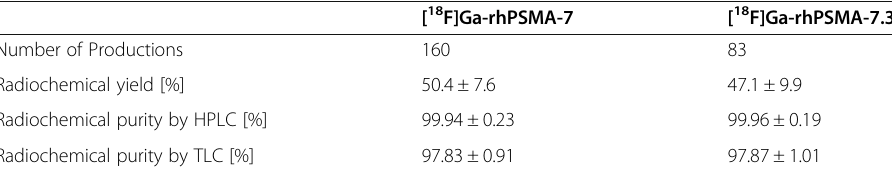
Table 3 Influence of the substitution of the diastereomeric precursor Ga-rhPSMA-7 (150 nmol, 231 μ g) by the equivalent amount of the single isomer Ga-rhPSMA-7.3 on radiochemical yield and radiochemical purity, as determined by radio-TLC and